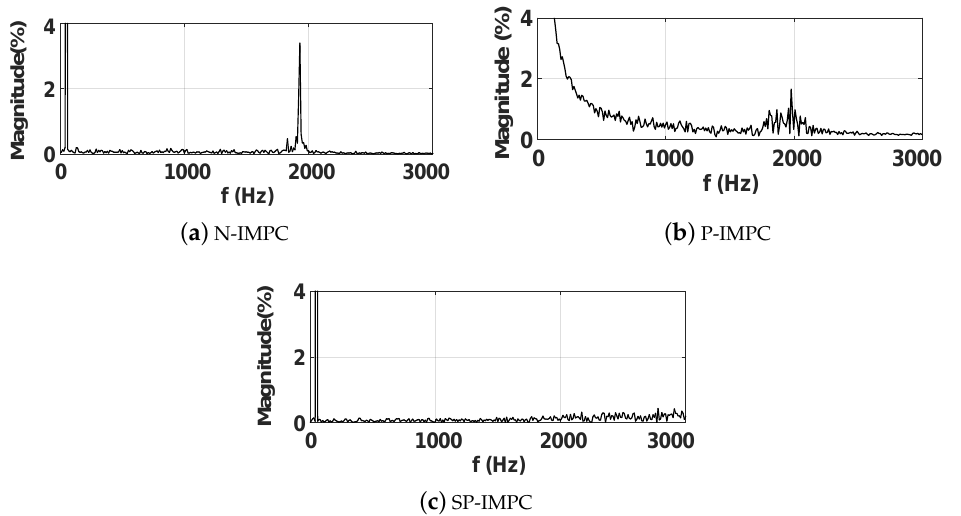
Figure 13. Obtained experimental spectrum results using three different frequency control methodologies with improved CF (IMPC). ( a ) Notch control; ( b ) periodic control; and ( c ) simple penalization control.